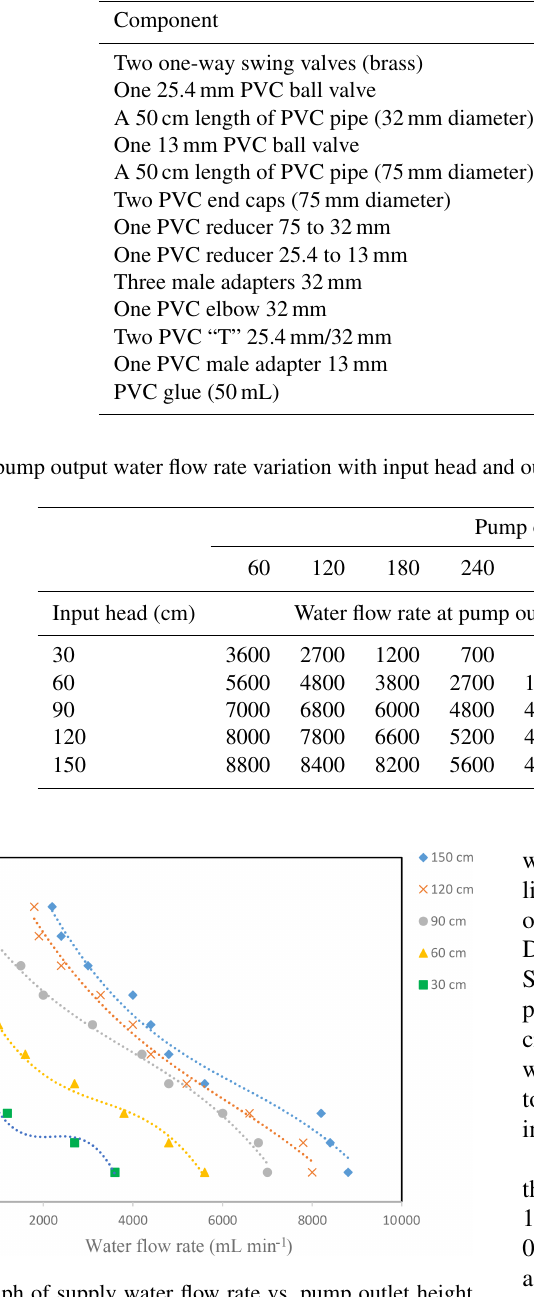
Figure 4. Graph of supply water flow rate vs. pump outlet height for various input head